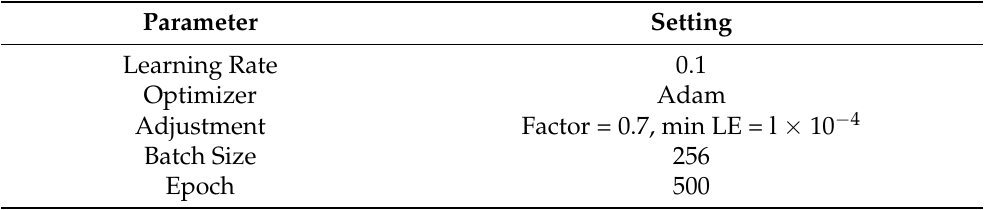
Table 3. Settings of the parameters chosen in the developed